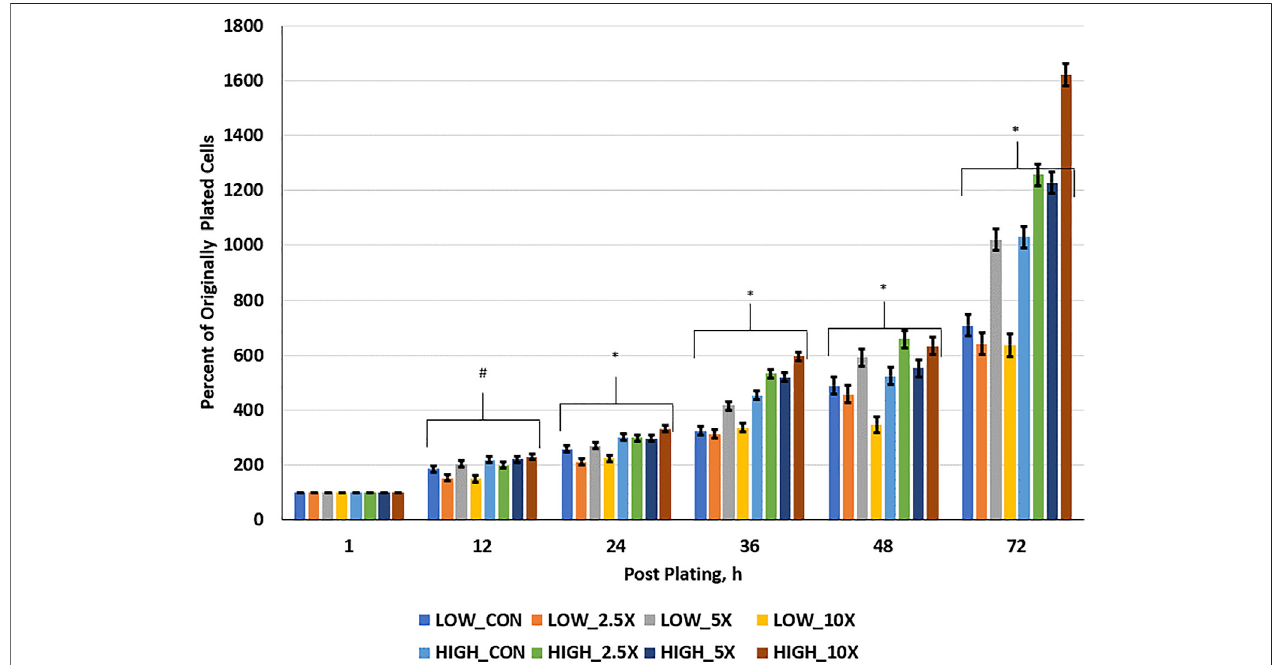
FIGURE1 | Cell growth rate isincreased inHigh cells withincreasing epigenetic modi fi ers (EM)and to×5 inLow cells. Three replicates per treatment per timepoint were measured. The error bars represent the average standard error of the mean within the glucose level. # indicates a tendency (0.05 < p < 0.10) for an interaction of glucose × EM. * indicates a signi fi cant ( p ≤ 0.05) interaction of glucose ×